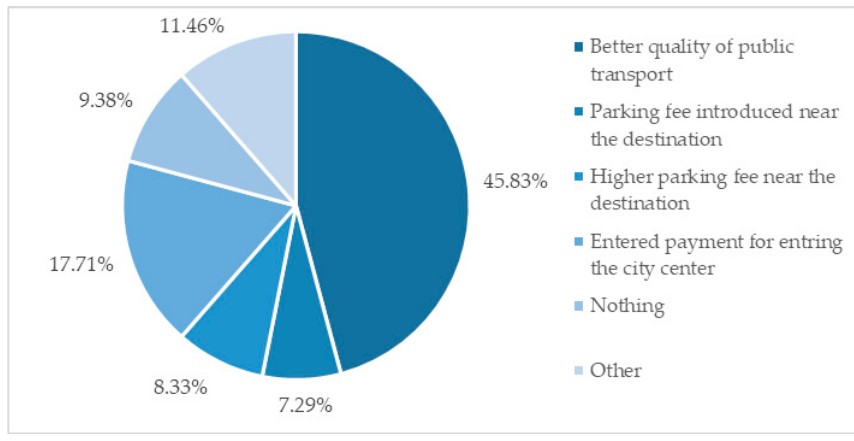
Figure 15. Solutions that, in the respondents’ opinion would contribute to the P&R parking use.